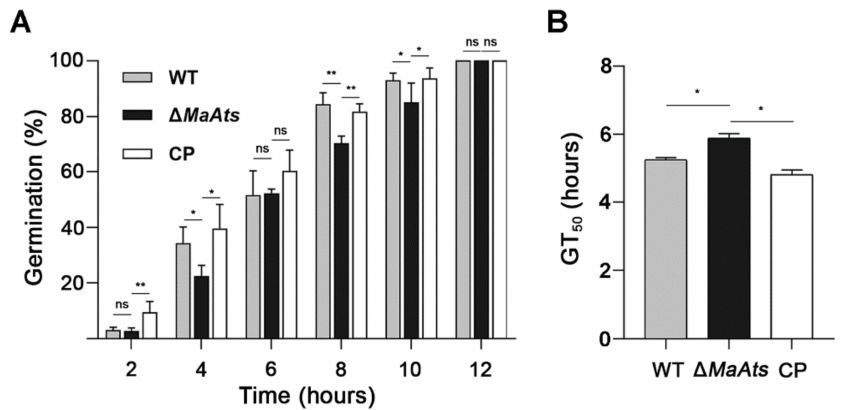
Figure 2. The deletion of MaAts delayed the conidial germination. ( A ) The germination rates of conidia of each strain on nutrient-rich 1/4 SDAY medium. ( B ) The mean 50% germination time (GT 50 ) of each strain. Asterisk indicates significant difference at (*) p < 0.05, (**) p < 0.01, (ns) p > 0.05.